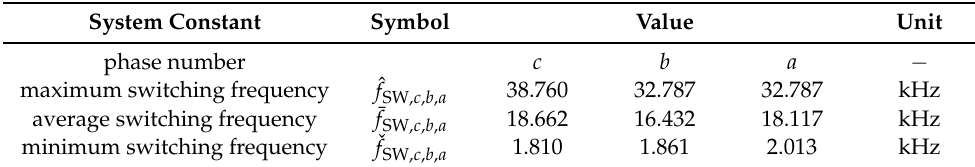
Table 5. Switching frequency values for all phases.